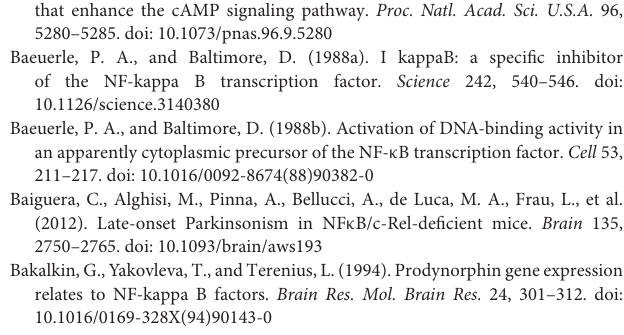
expression of the NF- κ B target gene Igf2 was not elevated in